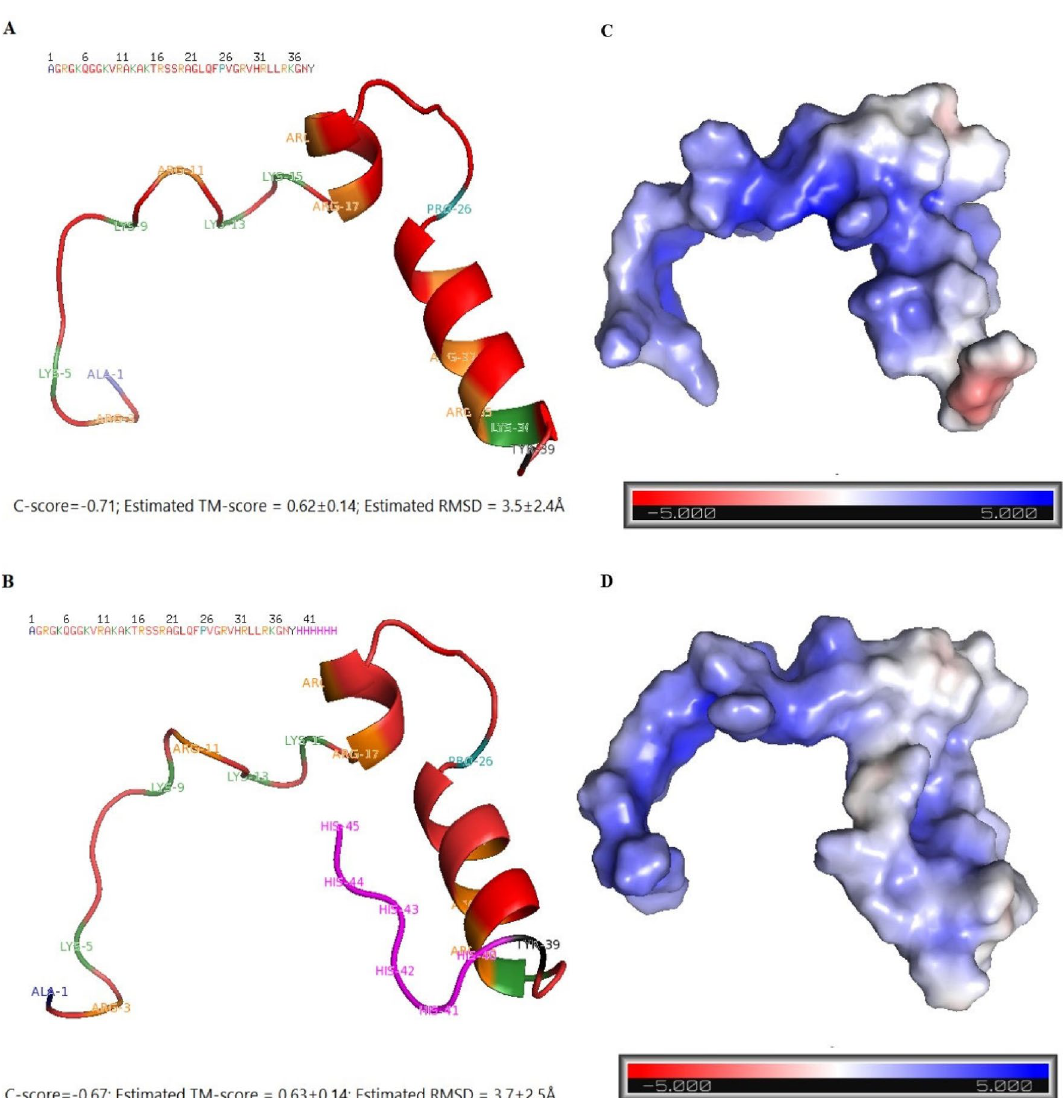
Figure 11. The predicted structures of ( A ) buforin I and ( B ) recombinant buforin I modeled by I-TASSER; ( C ) buforin I and ( D ) recombinant buforin I molecular electrostatic